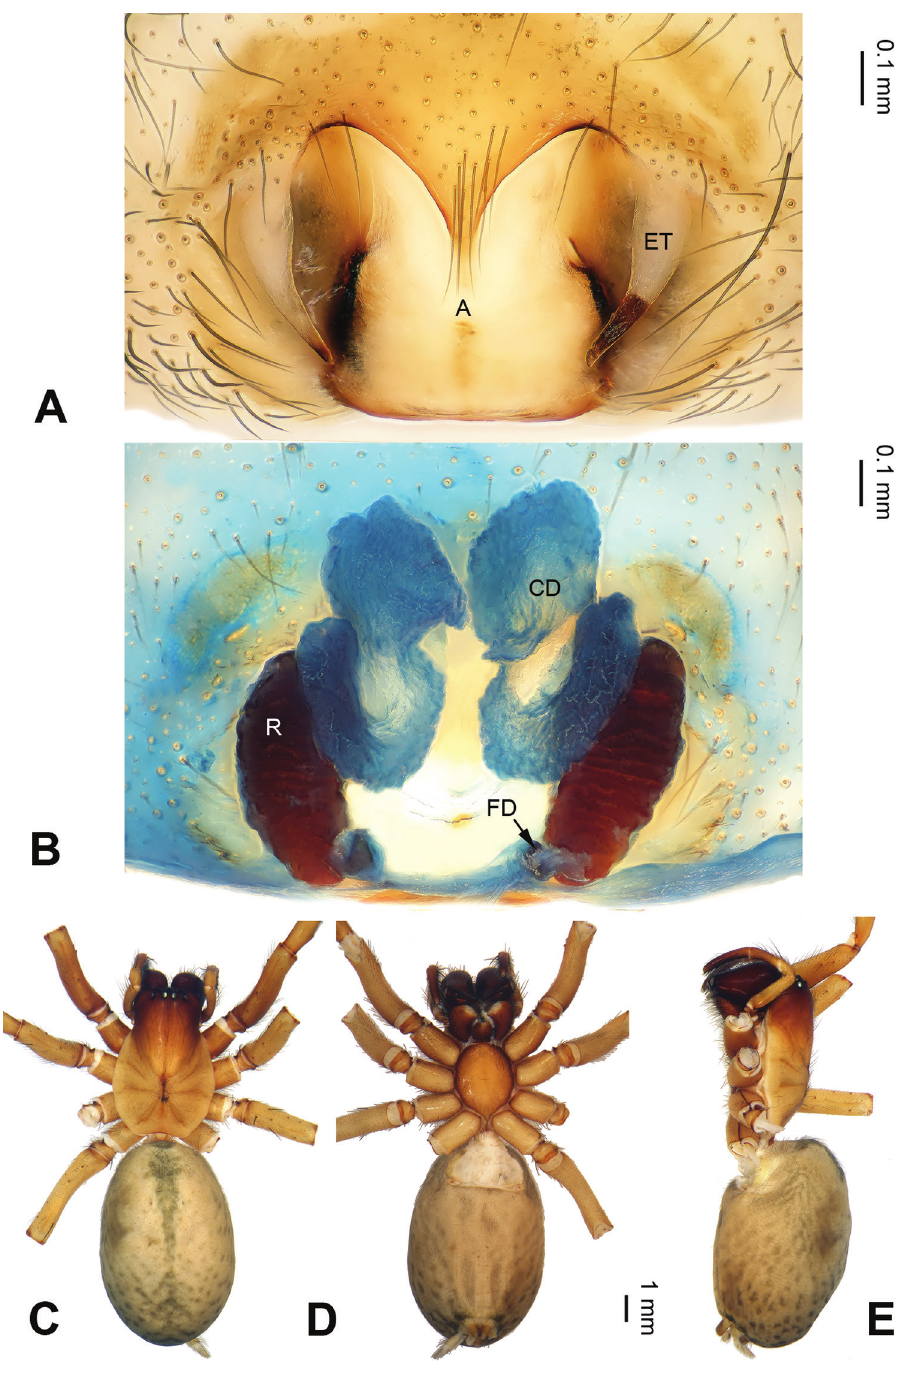
Figure 3. Pireneitega muratovi sp. n., female holotype. A Epigyne, ventral B Vulva, dorsal C Habitus, dorsal D Habitus, dorsal E Habitus, ventral view. Scale bars equal for C, D, E